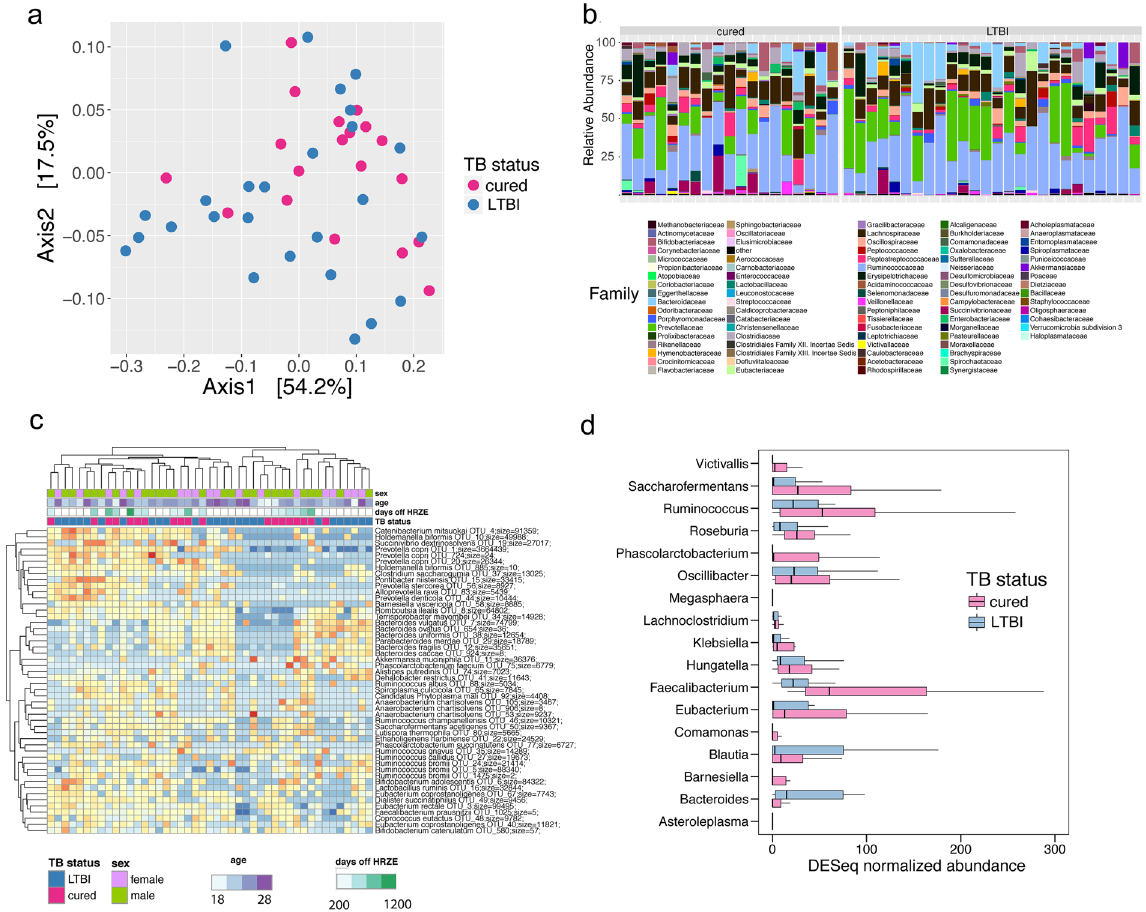
Figure 4. TB treatment induces a lasting alteration in microbiome structure. ( a ) DPCoA ordination plot of cured cases compared to LTBI controls based on 16S rDNA sequencing. ( b ) Family level taxonomic distribution of the intestinal microbiota from subjects with LTBI or who are cured. ( c ) Heatmap of the 40 most abundant taxa generated with DESeq2 showing unsupervised clustering of cured vs. LTBI subjects. Age and sex are also shown but were not accounted for the in DESeq model. The number of days that each patient has been off treatment is also shown. Genus and species names are based on OTU identification (Supplementary Table